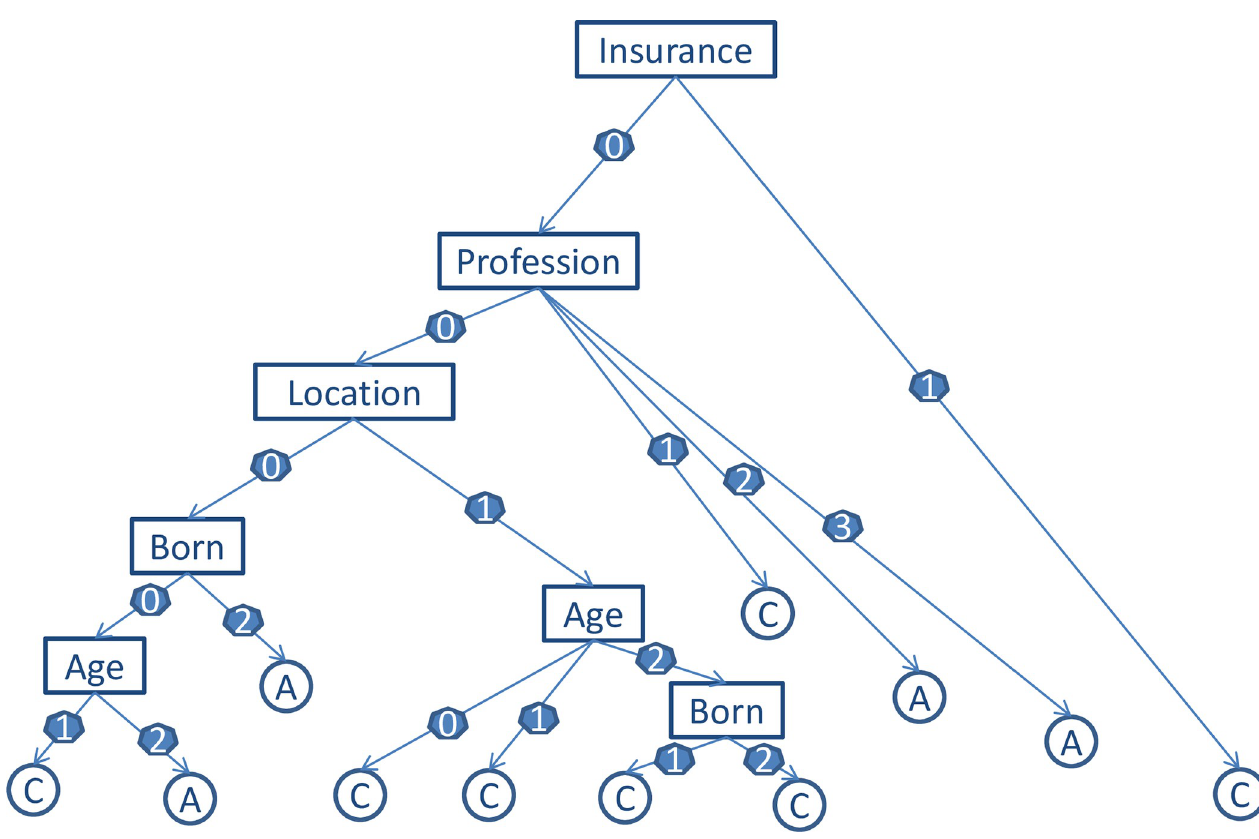
Fig 1. The final decision tree